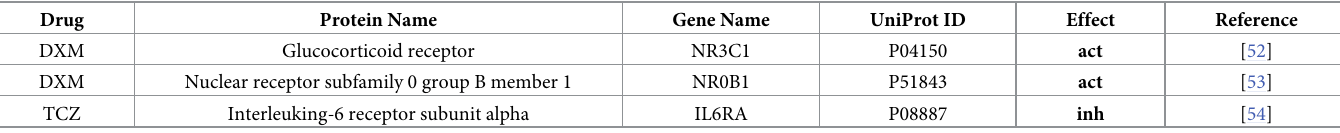
Table 1. Summary of the drug characterization at target